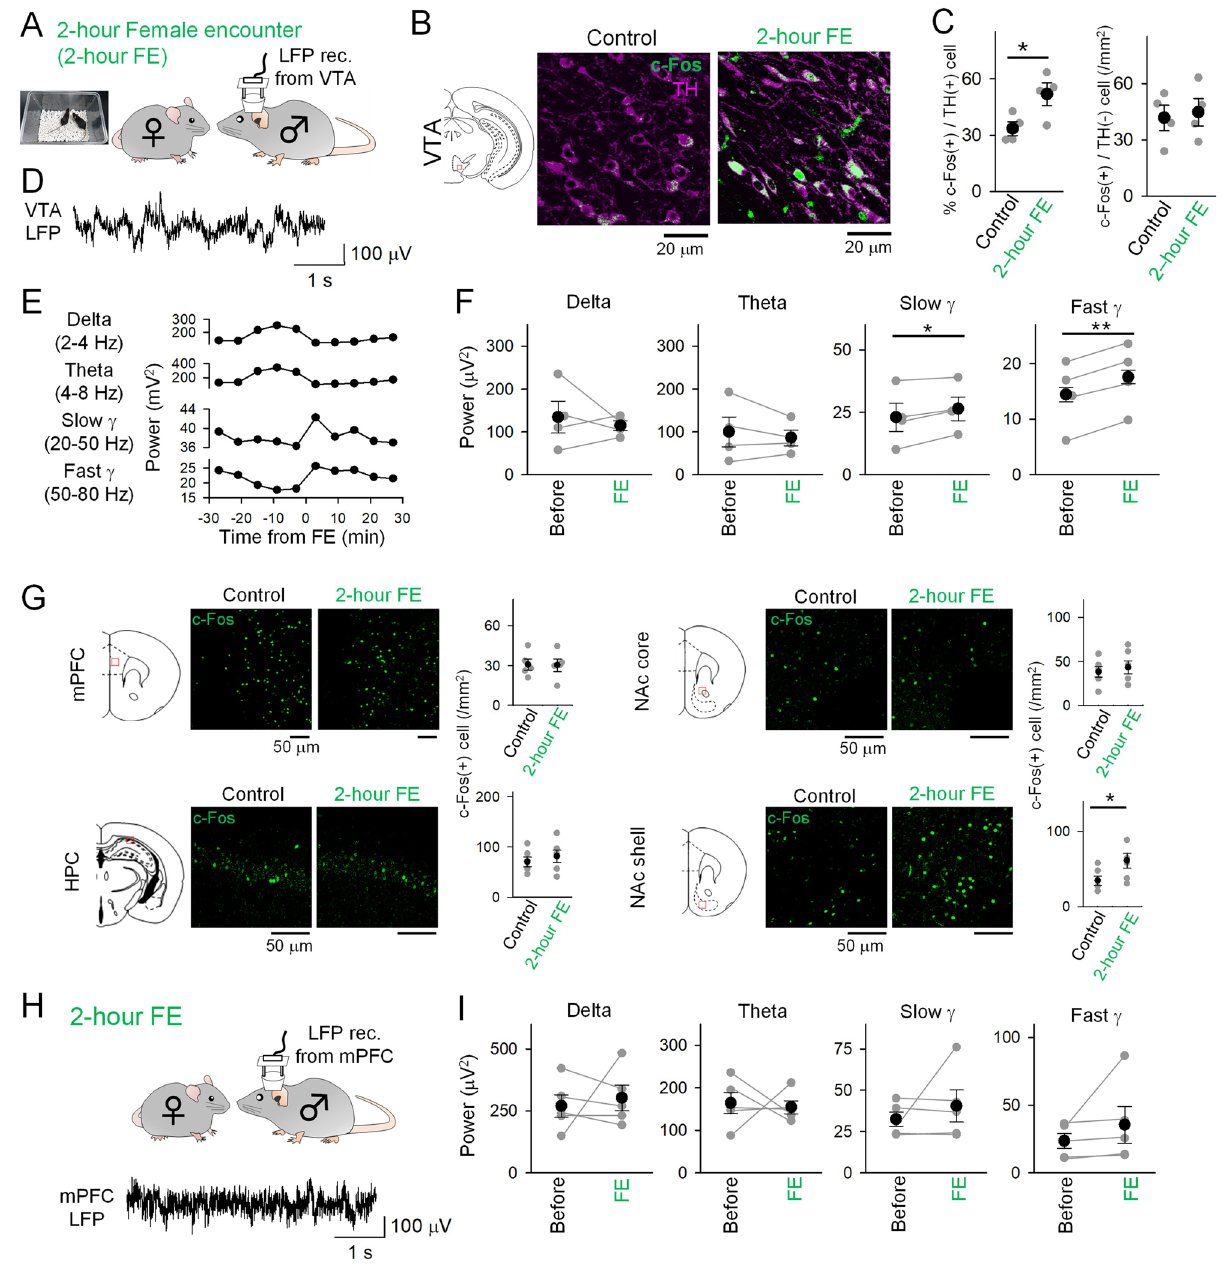
Figure 2. Activation of the VTA neurons in male mice by a female encounter. ( A ) A male mouse was allowed to freely interact with a female mouse for 2 h, termed a female encounter (FE). Some mice were implanted with electrodes in the VTA. ( B ) Representative images of the VTA neurons labeled with anti-c-Fos (green) and TH (magenta) antibodies after the FE. ( C ) (Left) The percentages of both c-Fos-positive and TH-positive neurons among all TH-positive neurons in the VTA (Control, n = 4 mice; 2-h FE, n = 4 mice) (Right) The percentages of c-Fos-positive and TH-negative neurons among TH-negative neurons in the VTA (Control, n = 4 mice; 2-h FE, n = 4 mice). * P < 0.05. ( D ) Local field potential (LFP) signals were recorded from the VTA during the FE. ( E ) FE-induced time changes in the VTA LFP power at each frequency band in mice. ( F ) Comparisons of the VTA LFP power between 30-min before (before) and 30-min after (FE) the onset of FE in all mice ( n = 4 electrodes from 4 mice). Each gray dot represents one mouse. * P < 0.05, ** P < 0.01. ( G ) (Left) Immunohistochemical analysis of c-Fos in each brain region in male mice. (Right) Quantification of c-Fos-positive neurons in each brain region (Control, n = 5–6 mice; 2-h FE, n = 5–6 mice). ( H ) LFP signals were recorded from the mPFC during the FE. ( I ) Similar to E but for mPFC LFP power ( n = 5 electrodes from 3